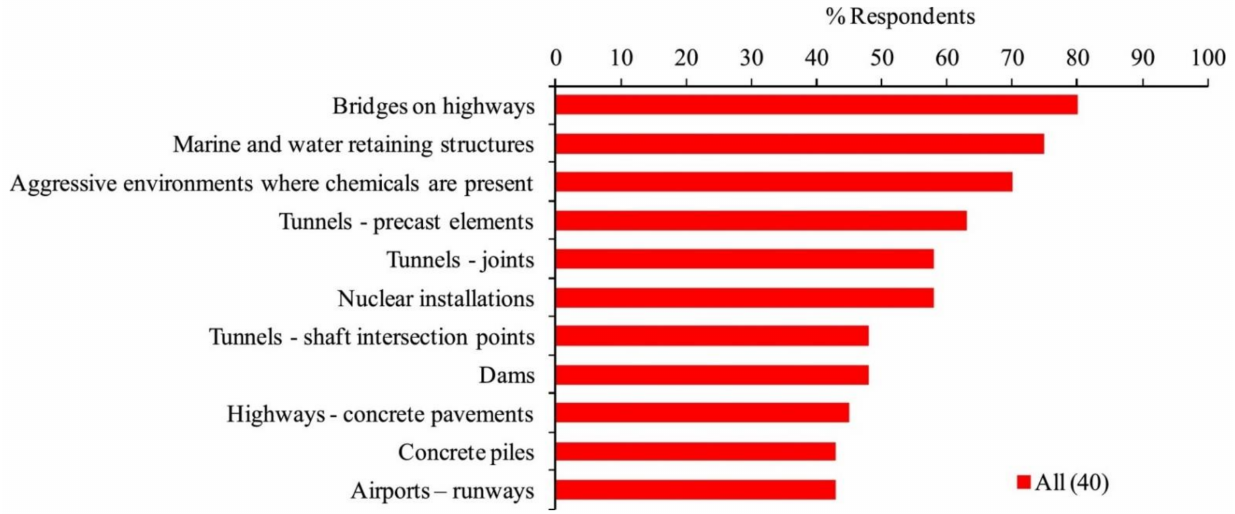
Figure 15. Applications for which SHC could have particular appeal (Adapted with permission from Elsevier